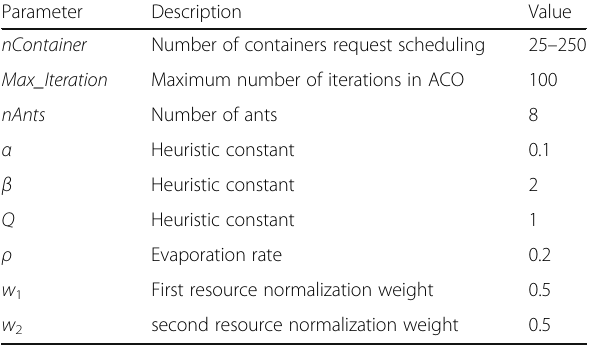
Table 4 Parameter settings of the conducted experiments